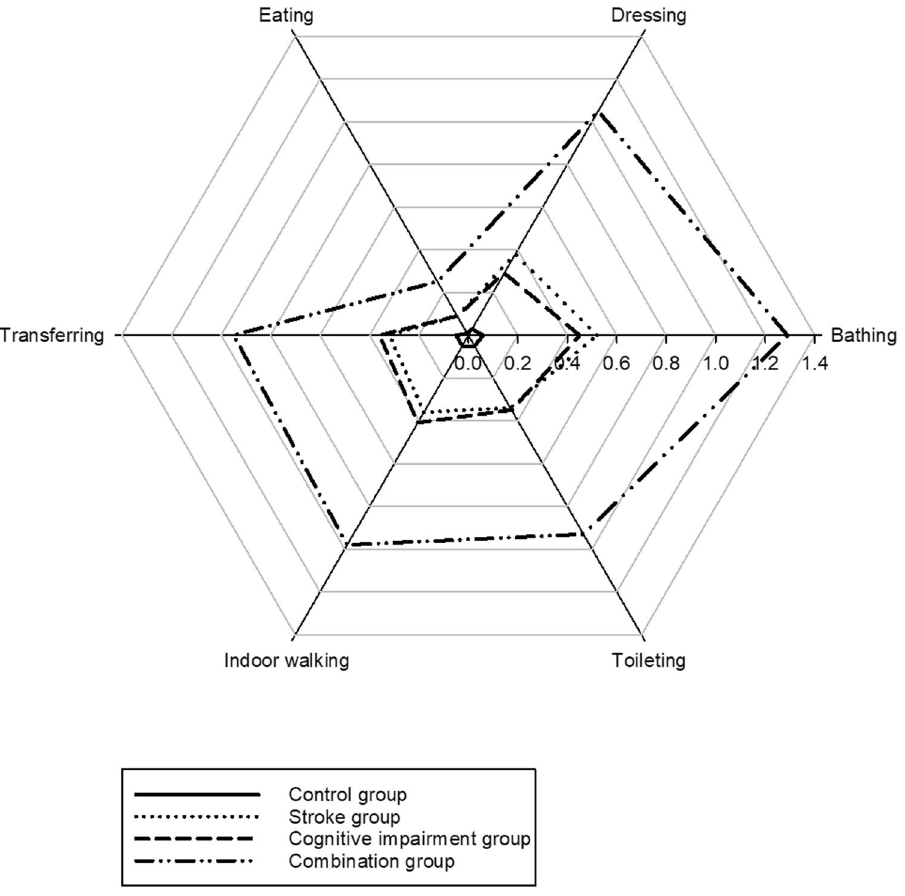
Figure 1. The level of difficulty for each basic activity of daily living (BADL) task presentated as mean values among the control, stroke, cognitive impairment, and combination groups. (0): no difficulty; (1): some difficulty; (2): great difficulty; and (3): inability to perform the